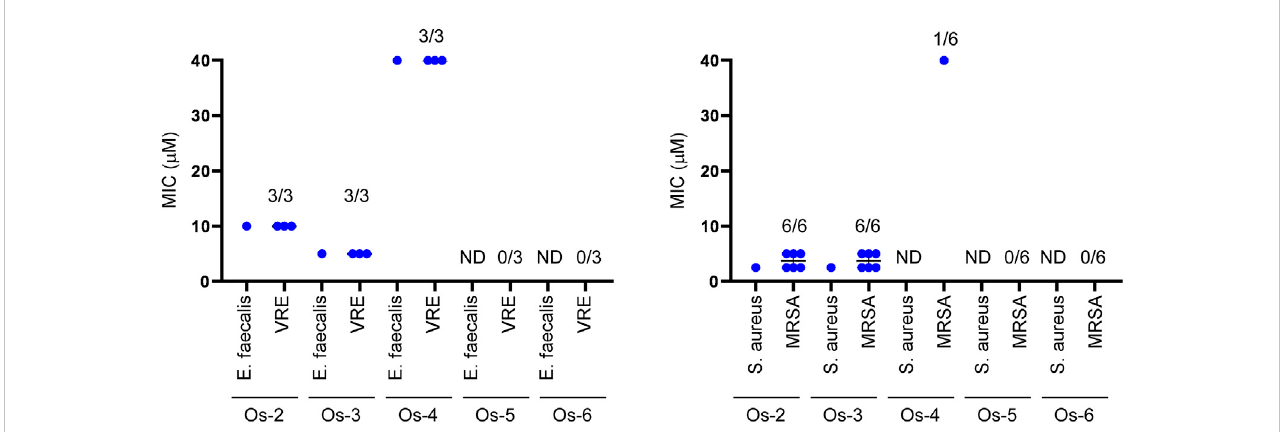
FIGURE 11 Os-2 and Os-3 complexes exert bacteriostatic activity against reference strains and clinical VRE and MRSA isolates. The MIC values of the complexes were determined against the reference strains of S. aureus (ATCC29213) and E. faecalis . (ATCC29212) and against clinical VRE and MRSA isolates by microdilution assays (repeated at least twice in duplicates) as described in Materials and Methods. The numbers indicate how many isolates were susceptible to the compound out of those tested; i.e., 1/6 stands for 1 isolate was susceptible out of 6 tested. Abbreviations: MRSA —